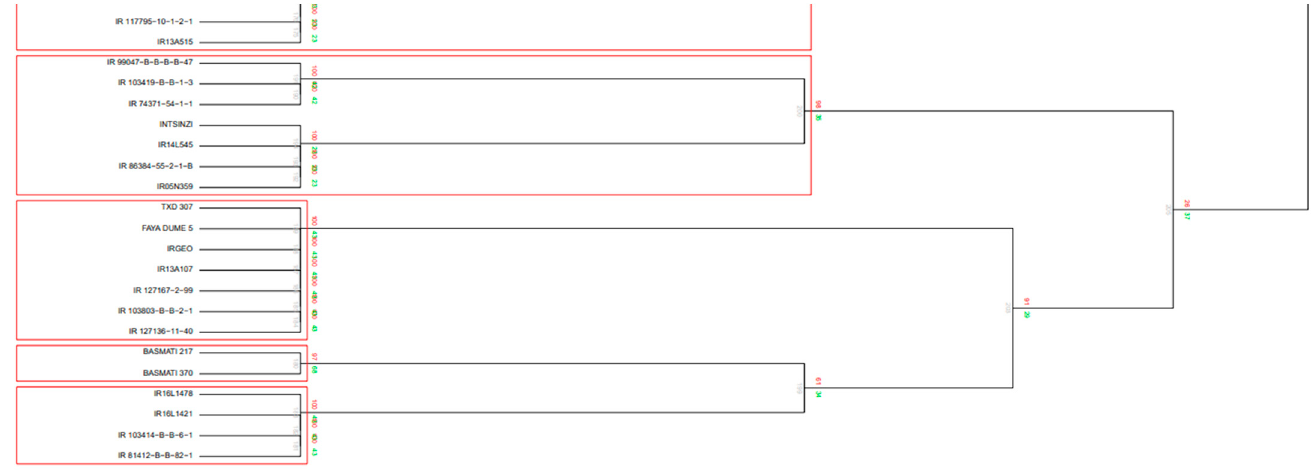
Figure A2. Dendrogram of 215 genotypes based on four targeted QTLs for drought tolerance.